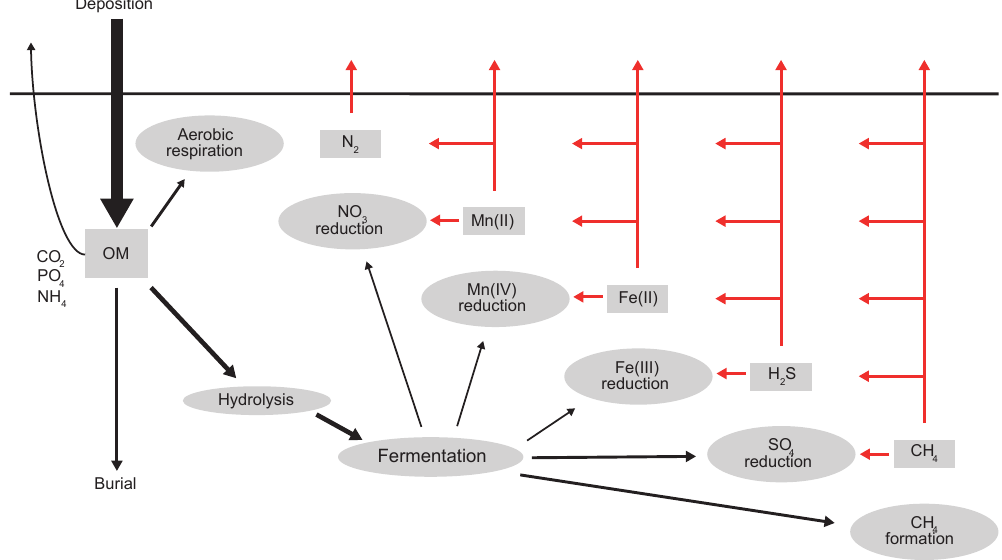
Figure 2. Conceptual model of organic matter (OM) degradation and reoxidation pathways (based on Jørgensen, 2006, and Middelburg and Levin, 2009). The red arrows reflect the fate of (energy-rich) substrates released during anaerobic mineralization.